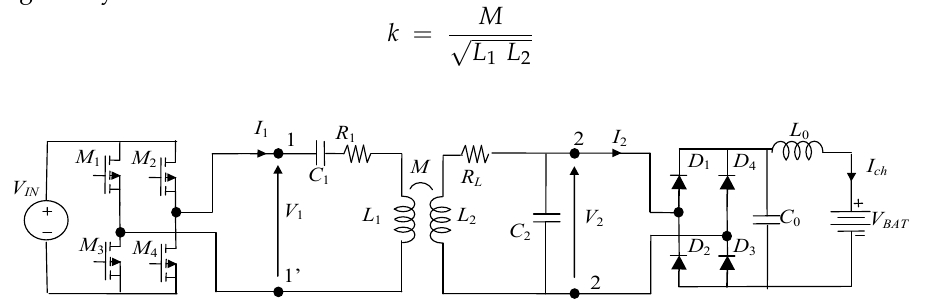
Figure 4. Electrical circuit of a WPT charging system with Series-Parallel (SP) compensation.